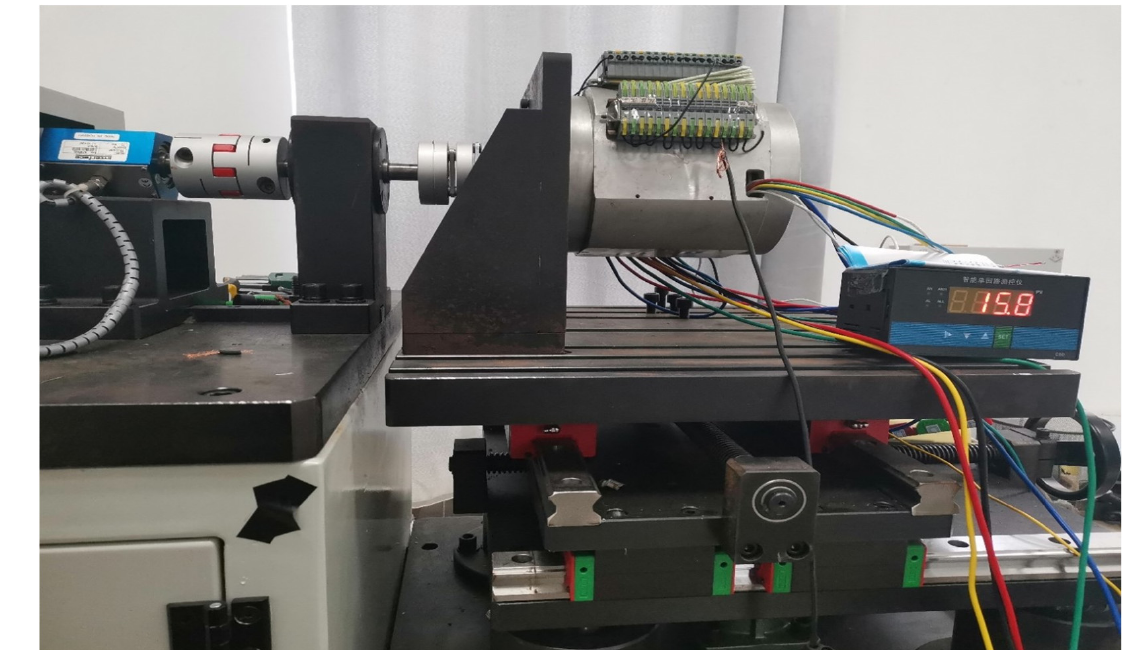
Figure 17. Prototype on the test platform.